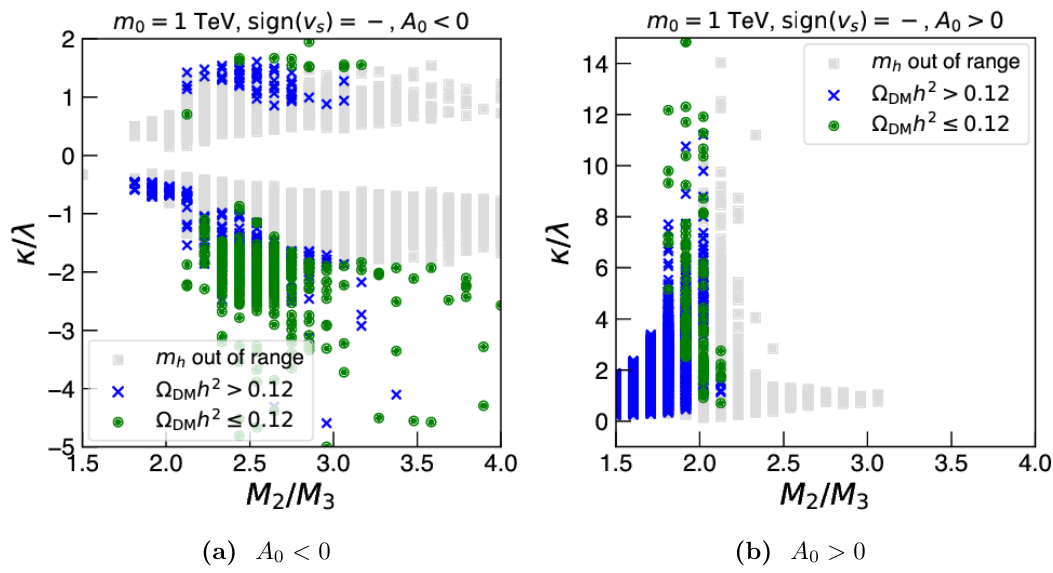
Figure 3. Scatter plots of (cid:20)=(cid:21) against M 2 =M 3 . The green dots and blue crosses represent the points where the relic abundance of the neutralino LSP is below and above the observed value, respectively. The points indicated by gray squares predict m h that is out of the acceptable mass range: 122 : 1 GeV < m h < 128 : 1 GeV. Here we (cid:12)x m 0 = 1 TeV and sign( v s ) = (cid:0)